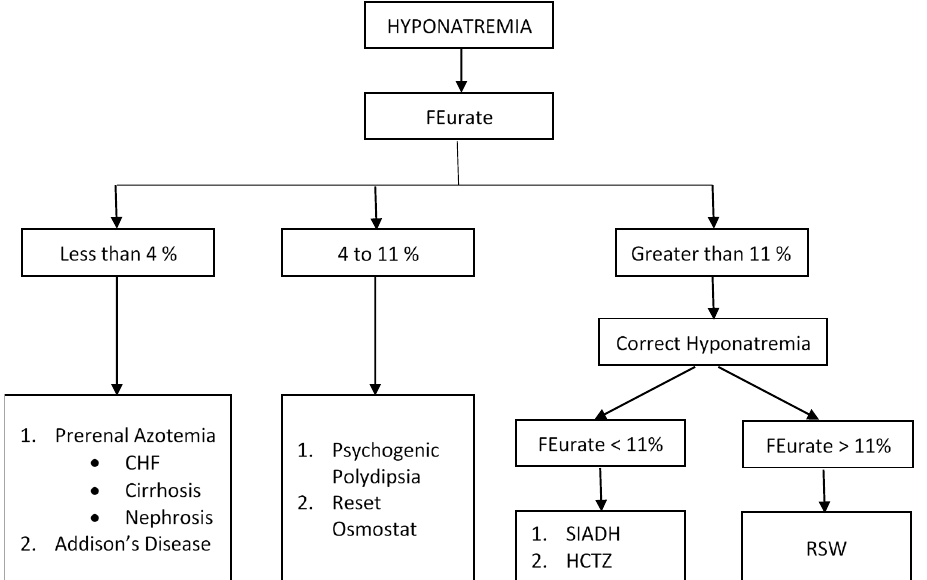
Figure 2. Algorithm utilizing FEurate to identify the different causes of hyponatremia. FEurate can be used to identify different causes of hyponatremia. Note the increased FEurate in patients with SIADH and RSW who have identical clinical and laboratory parameters when hyponatremic. The response to isotonic saline infusions in patients with increased FEurate >11% can be used to differentiate SIADH from RSW. Note how the changes in FEurate after correction of their hyponatremia with isotonic saline infusions can differentiate SIADH from RSW. See Figure 3.